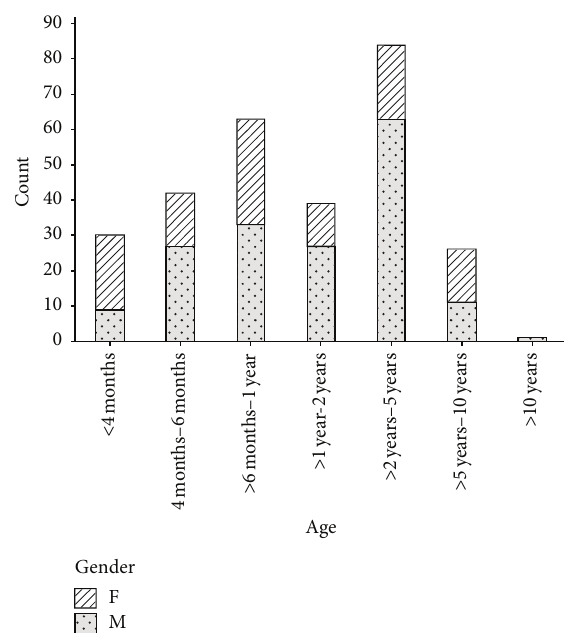
Figure 1: Age and gender distribution of the dogs included in the